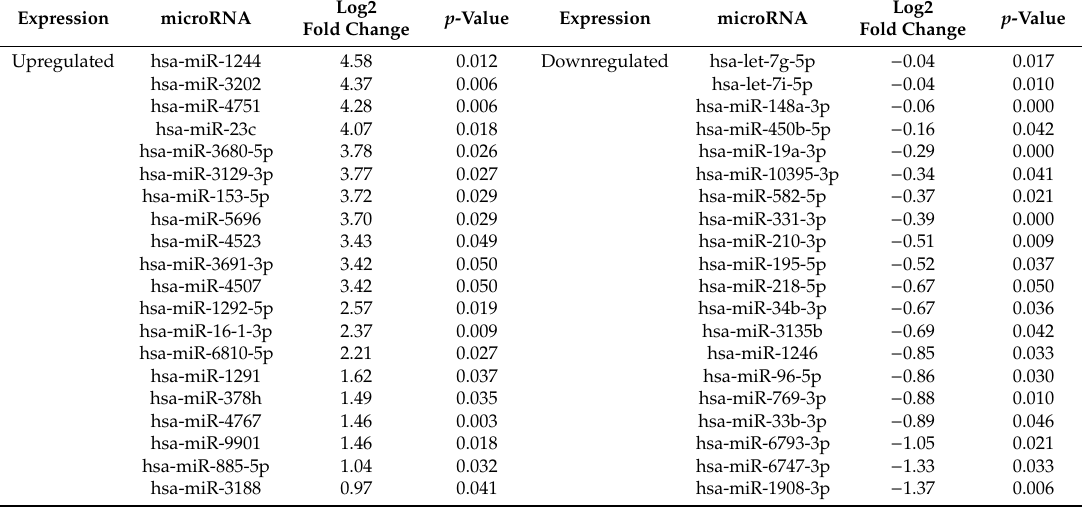
Table 1. Differentially expressed microRNAs in co-cultures of Trichophyton rubrum with human THP- 1 macrophages.